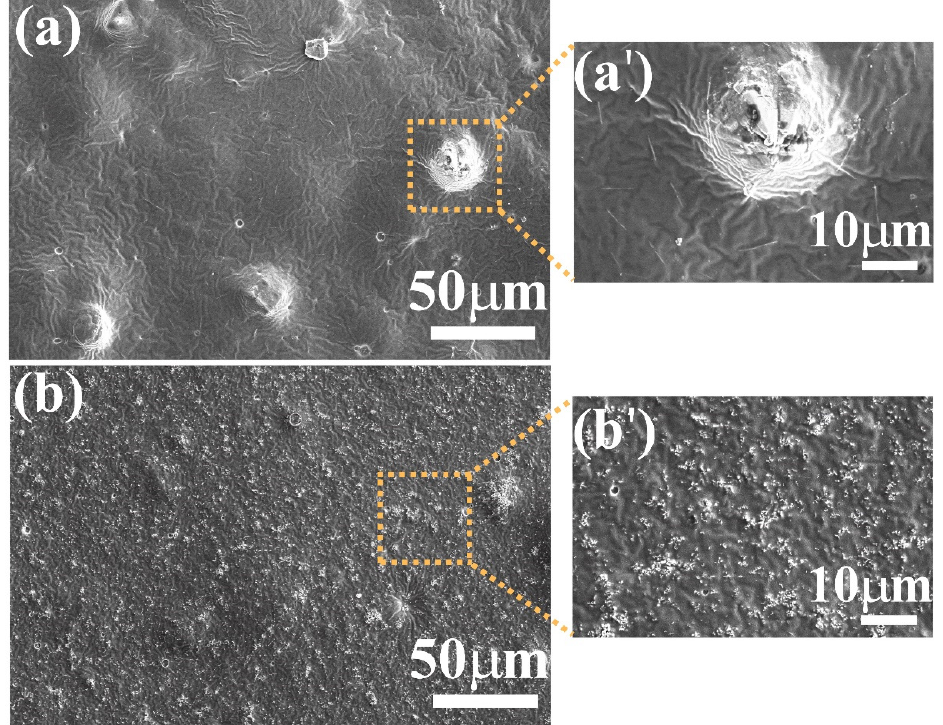
Figure 5. Characterization of the surface microstructure of ZnO coatings. SEM images of binder-A loaded with: ( a ) ZnO-aloe and ( b ) ZnO-starch. Magnified images ( a ′ ) ZnO-aloe and ( b ′ ) ZnO-starch were recorded in the area delimitated by the yellow dotted square in images ( a , b ), respectively.